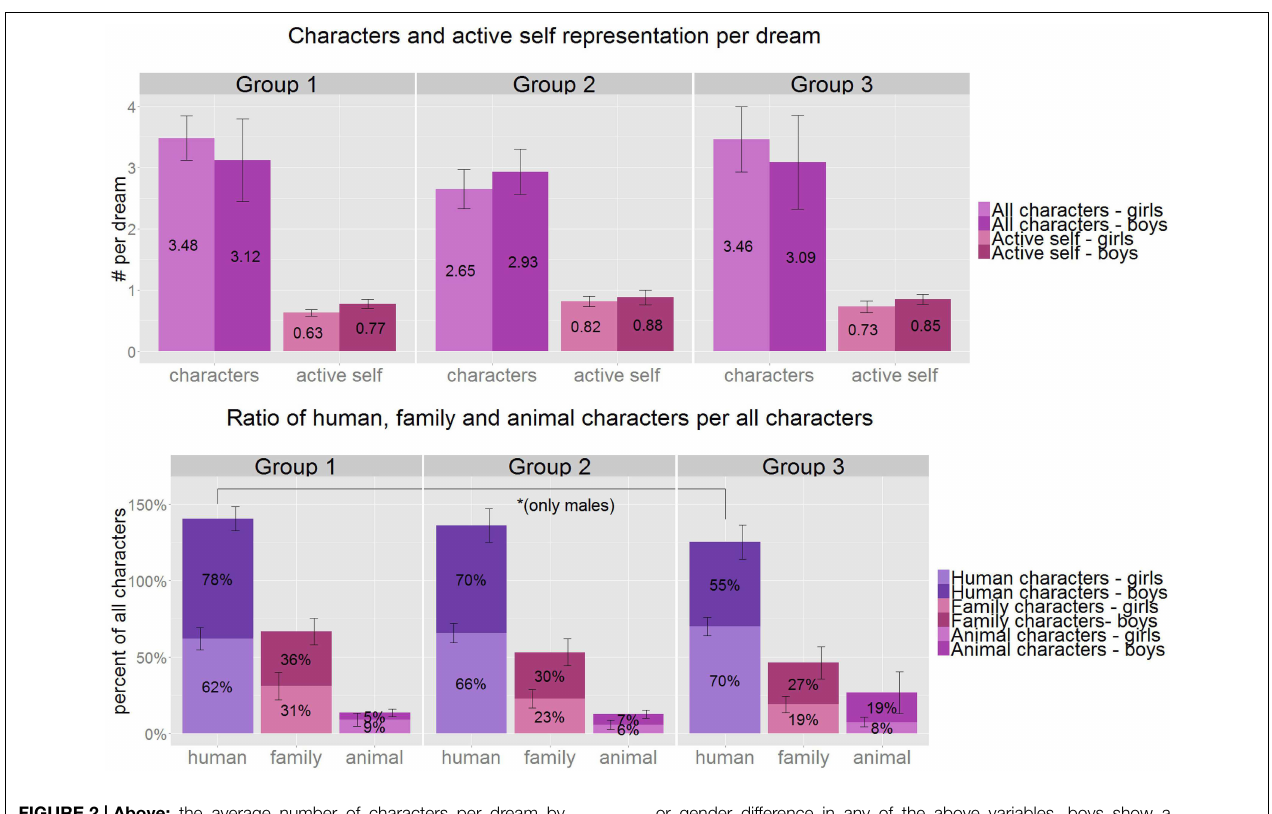
FIGURE 2 | Above: the average number of characters per dream by gender and age group (purple). The ratio of dreams with active self- representation compared to all dreams (pink). Below : the percentage of human, family, and animal characters of all characters appearing in the dreams by gender and age group. Although, there is no significant age